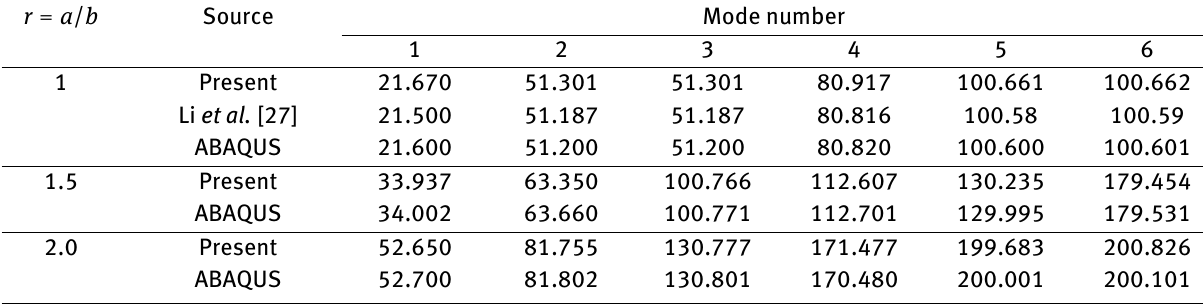
Table 5: Comparison of the first six frequency parameters Ω for the rectangular thin plate with S-S-S-S boundary condition. r = a /